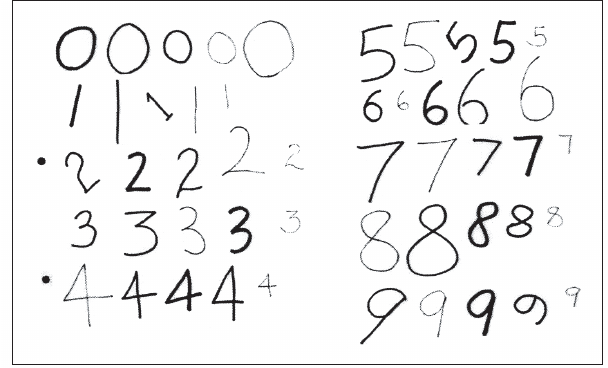
Figure A.1 shows samples of handwritten digits of group I.